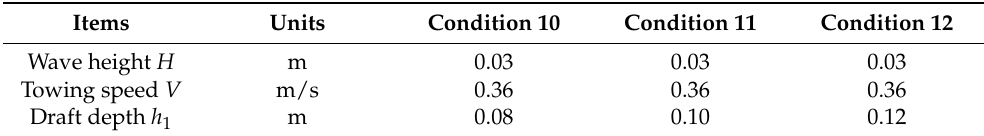
Table 7. Wet-towing conditions (draft depth as main variable).